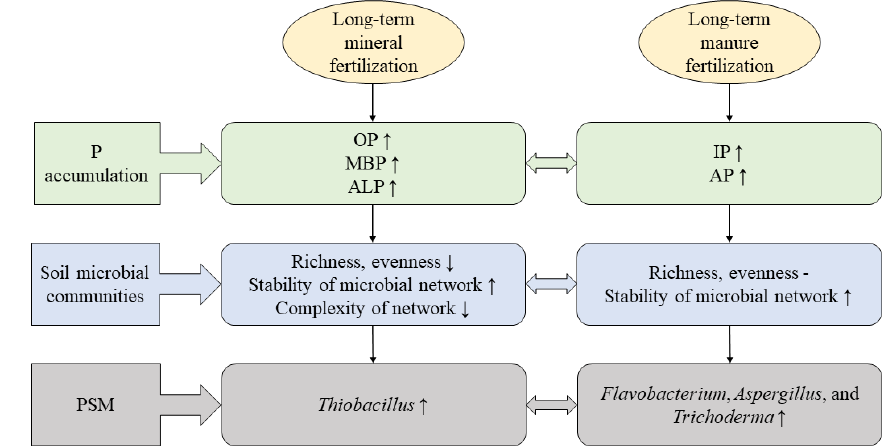
Figure 8. A diagrammatic sketch showing different responses of P accumulation, soil microbial communities and the PSMs after long-term mineral or manure fertilization. The ↑ indicates an increase; the – indicates no effect; the ↓ indicates a